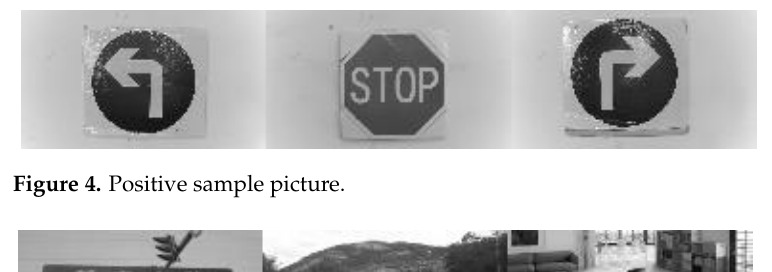
Figure 3. Sensor Layout.